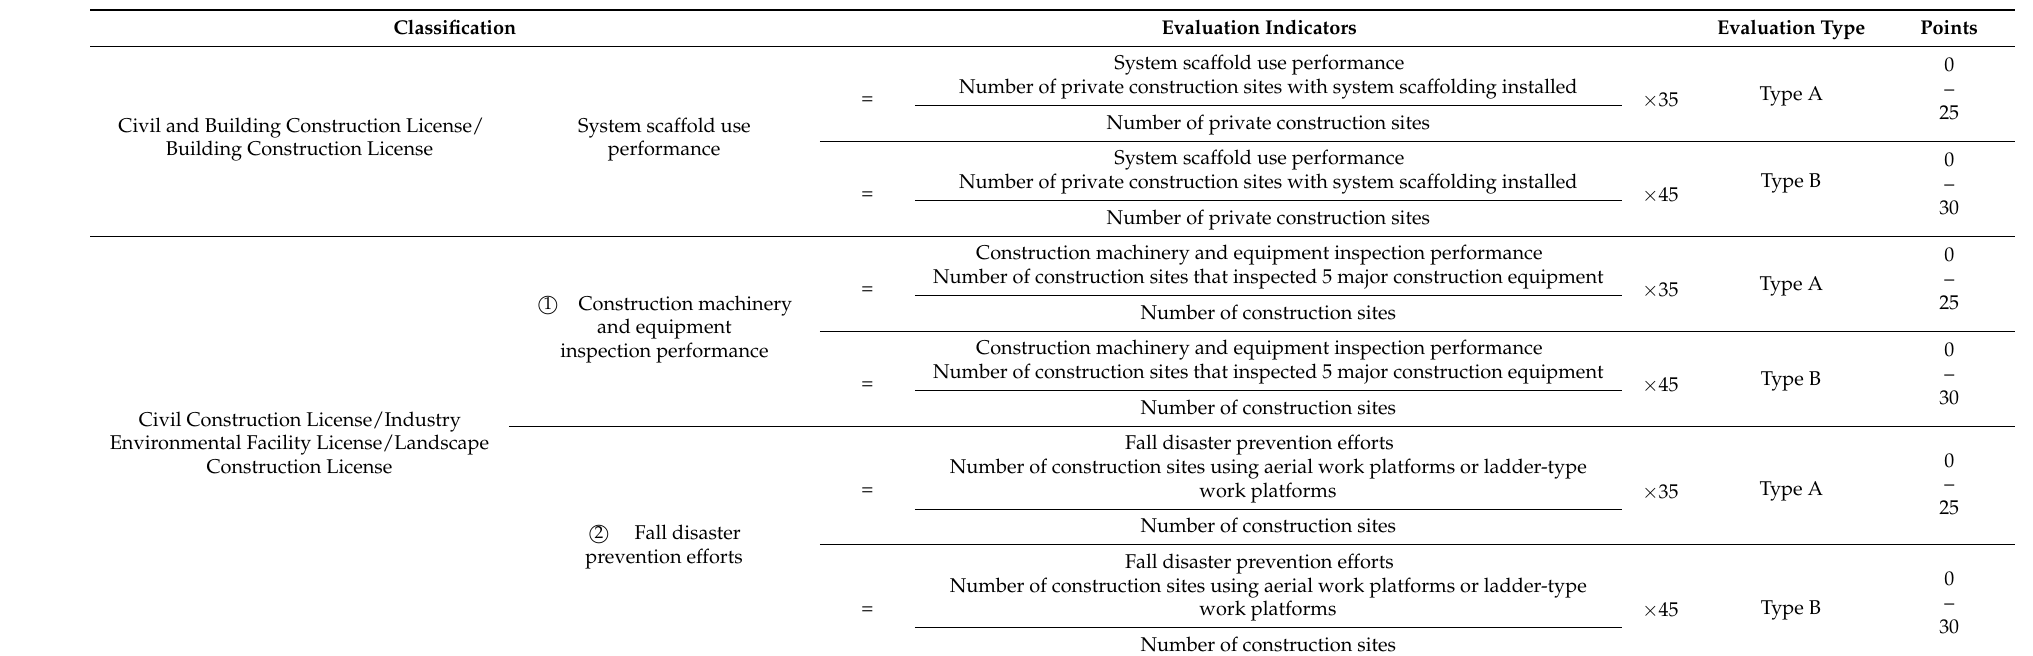
Table 13. Evaluation details for efforts to reduce accidents and